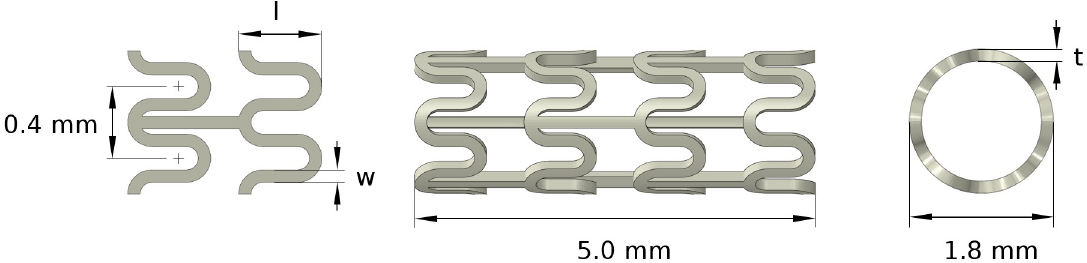
Fig 3. Geometry parameterisation in terms of strut width ( w ), strut thickness ( t ) and strut length ( l ).